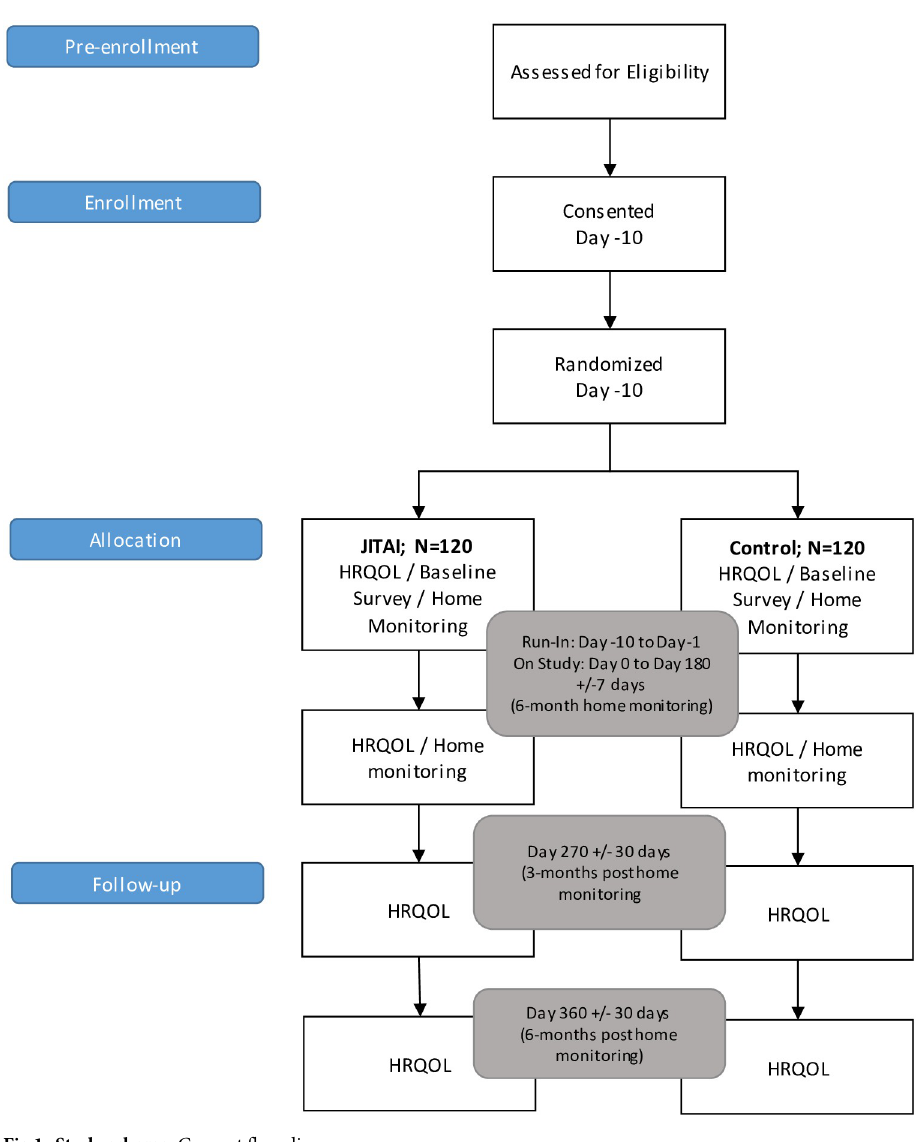
Fig 1. Study schema. Consort flow